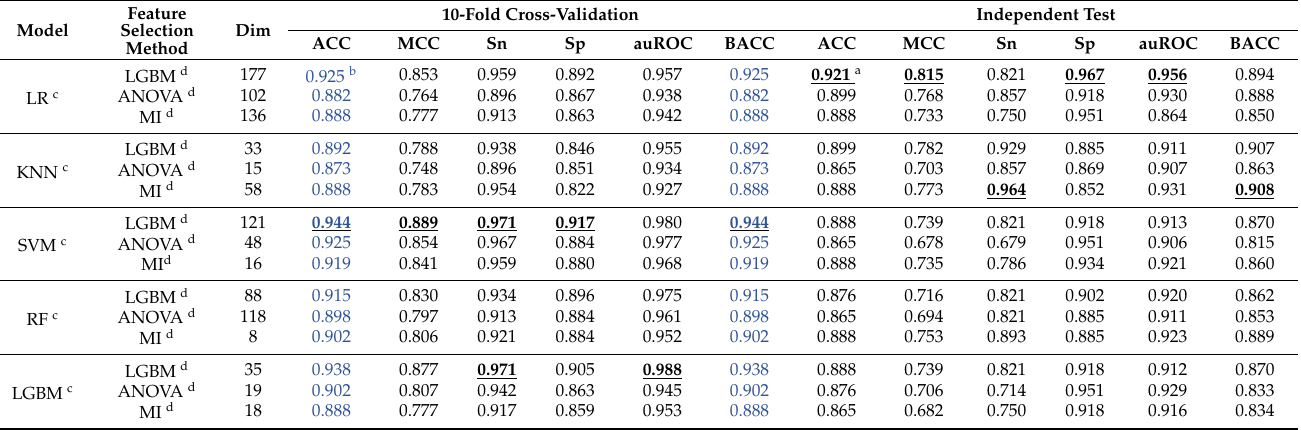
Table 2. Results of 10-fold cross-validation and independent testing of the five ML models developed using UniRep features selected with the three feature selection methods (LGBM, ANOVA, and